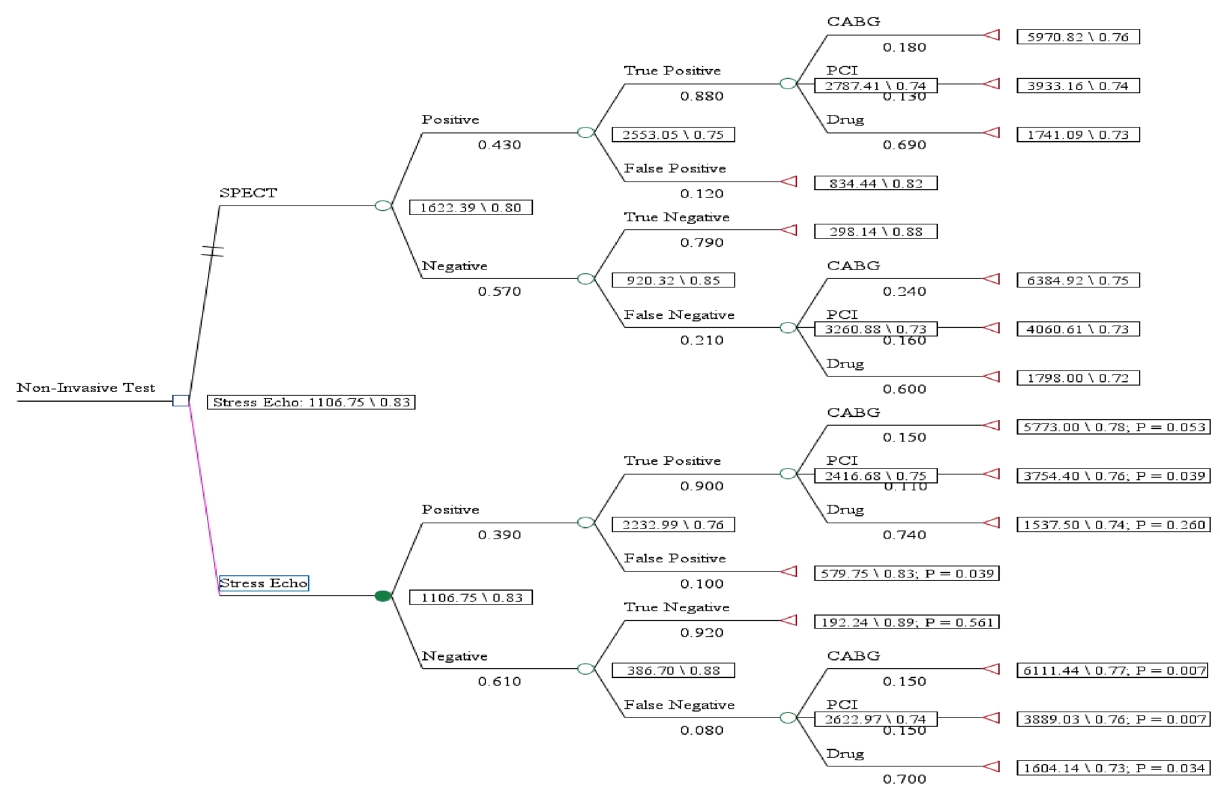
Figure 1. The results of the decision tree